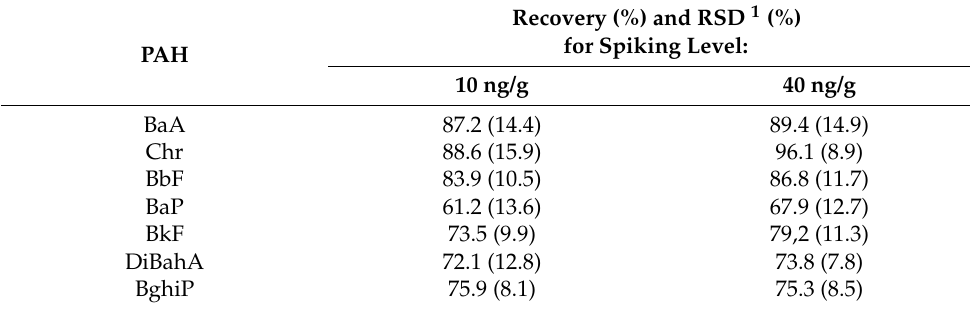
Table 3. Recoveries of PAHs spiked in meat samples ( n =